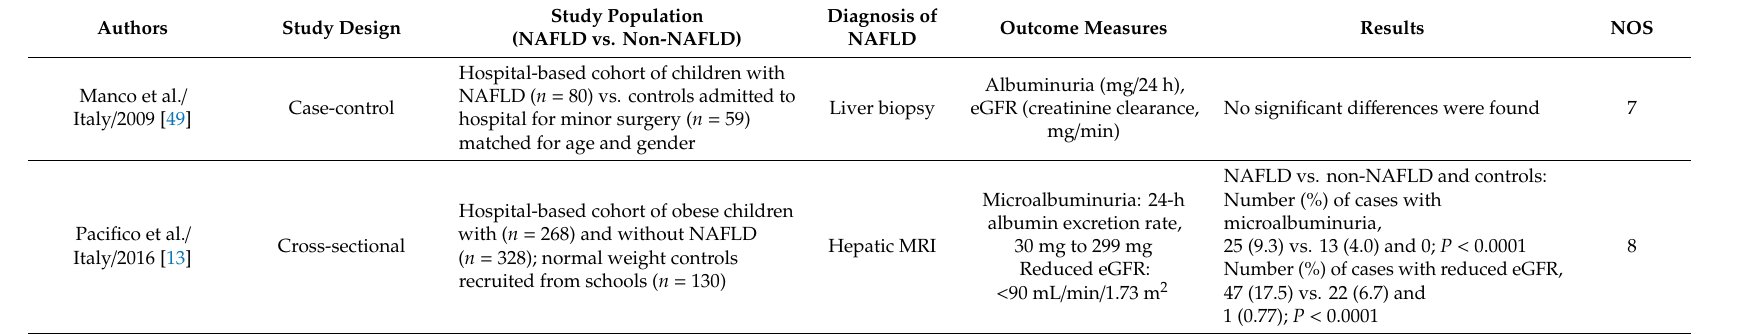
Table 5. Study characteristics for nonalcoholic fatty liver disease and renal function alterations.